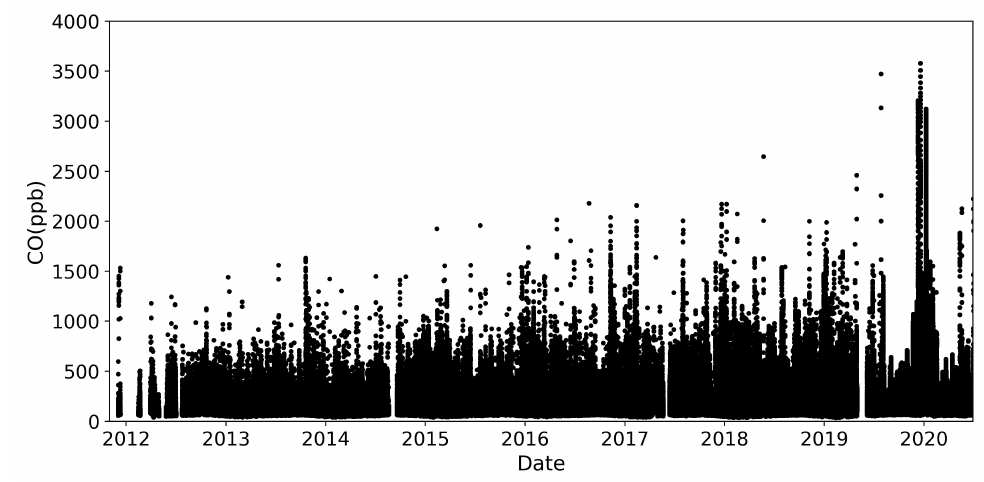
Figure 3. Time series of surface CO from April 2011–June 2020 recorded by the in situ FTIR at Wollongong.